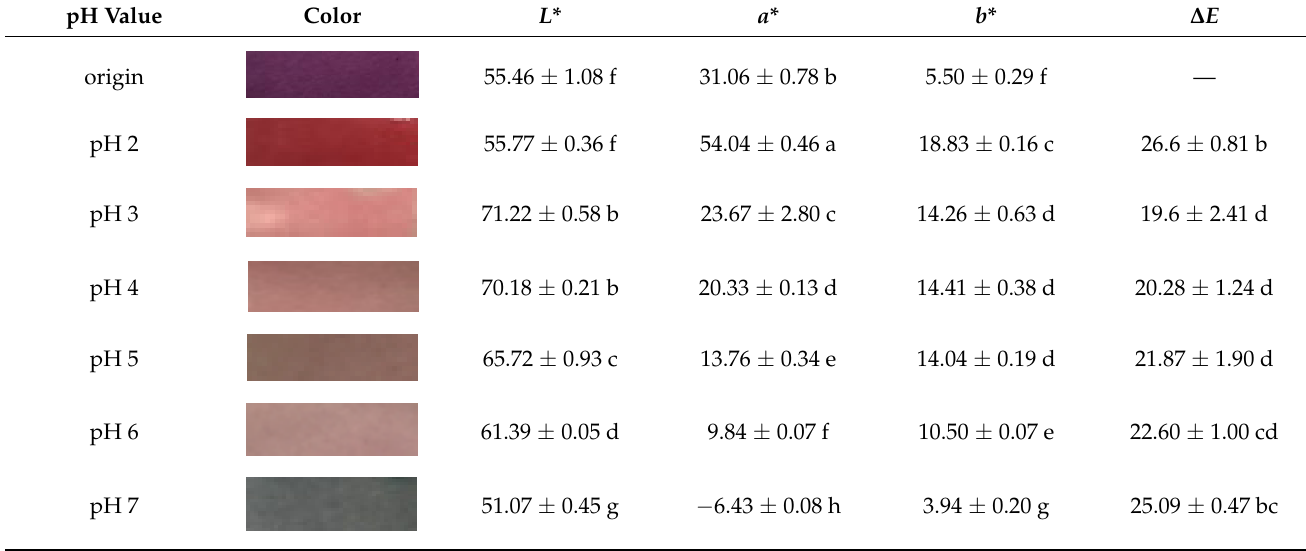
Table 2. Color parameters of the RCP/PVA film after immersion in different pH buffer solutions.